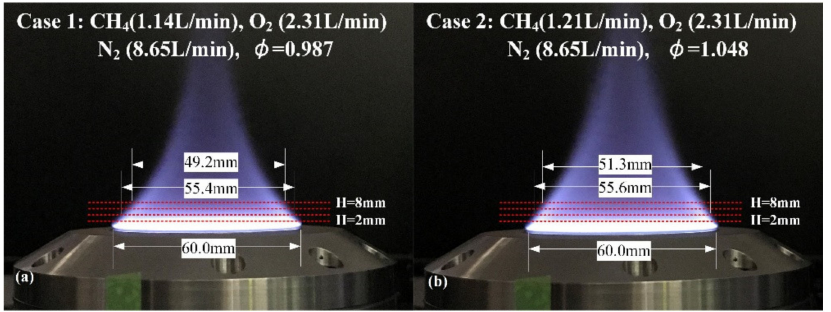
Figure 11. Images of the flame with di ff erent stoichiometric ratios. ( a ) φ = 0.987 ( b ) φ =